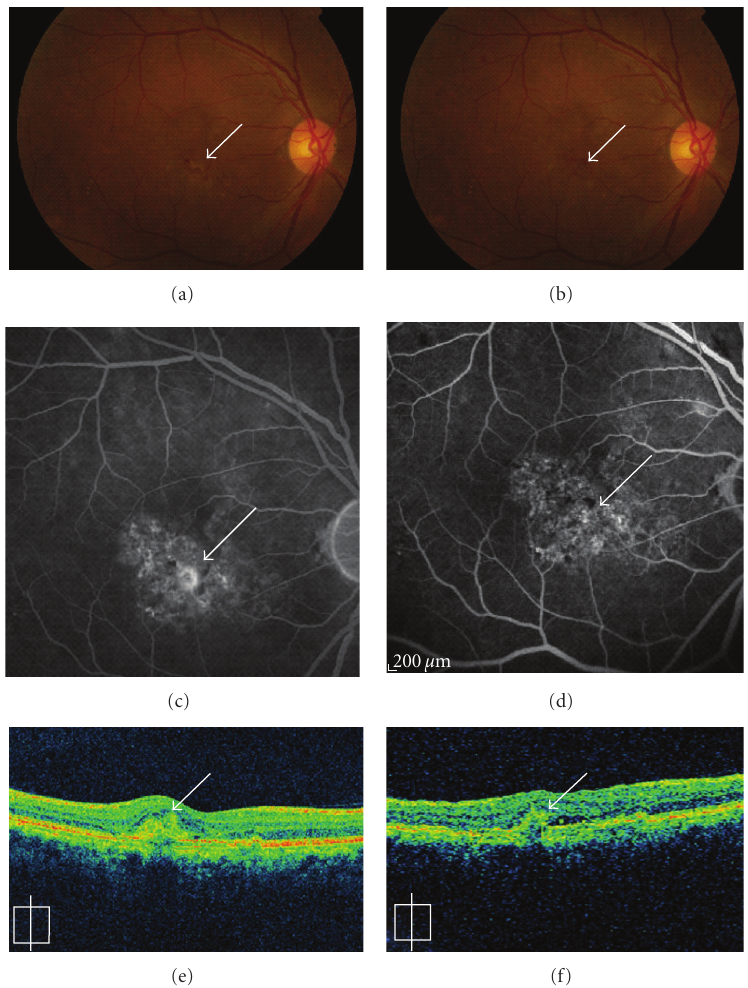
Figure 5: A 61-year-old male showed CNV (arrows) due to AMD (a). Fluorescein angiography (FA) showed predominantly classic CNV (c), and optical coherence tomography (OCT) revealed a subretinal lesion before treatment (e). After the oral administration of alendronate for three months, the CNV regressed remarkably (b) and no leakage was observed using FA (d). A remarkable decrease in the size of the subretinal lesion was observed using OCT